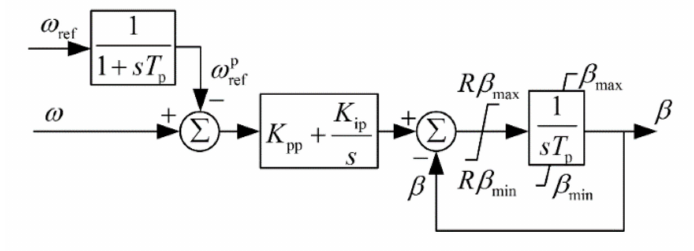
Figure 3. DFIG pitch angle control model for adjusting pitch